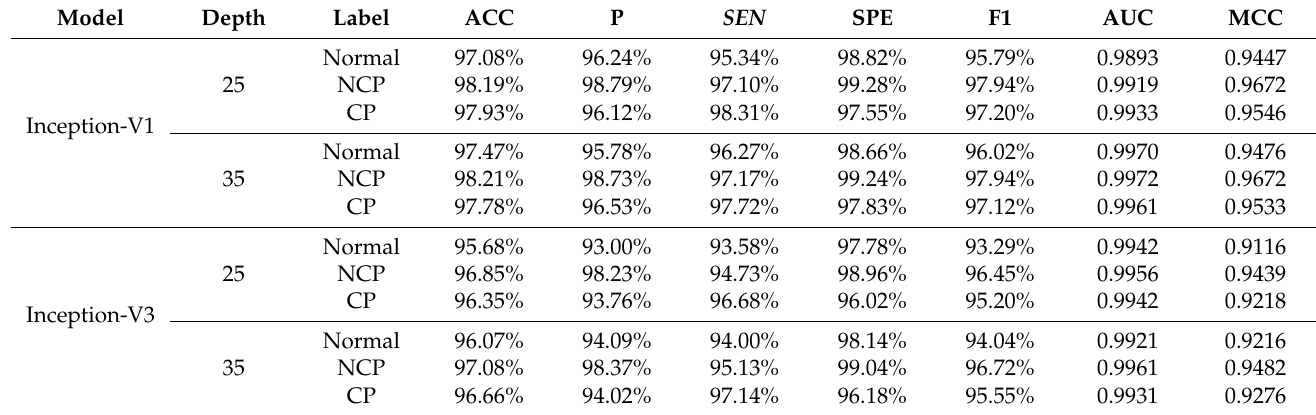
Table 8. Soft-voting ensemble models—Class-wise performances for Inception-V1 and Inception-V3 using 25 and 35 slices in terms of balanced accuracy, precision, sensitivity, specificity, F1-score, Area Under the ROC Curve, and Matthews Correlation